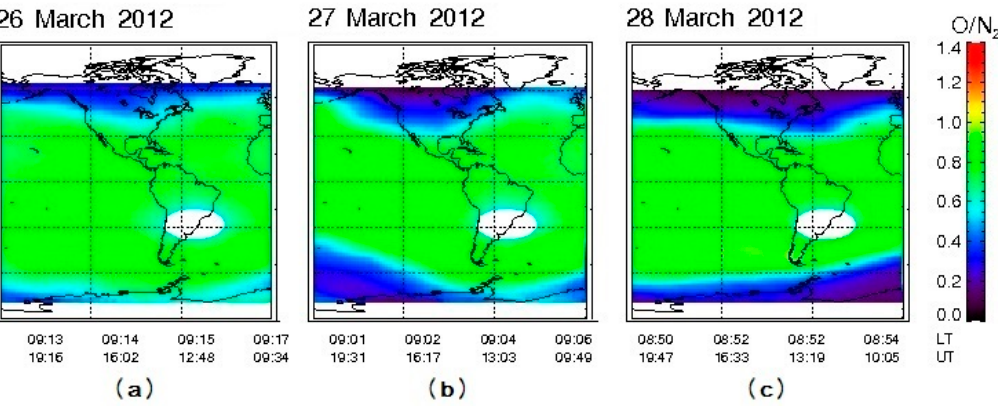
Figure 9. Thermospheric O/N 2 ratio during ( a ) 26 March (quiet day), ( b ) 27 March (partially MP of the storm) and ( c ) 28 March (partially RP of the storm).